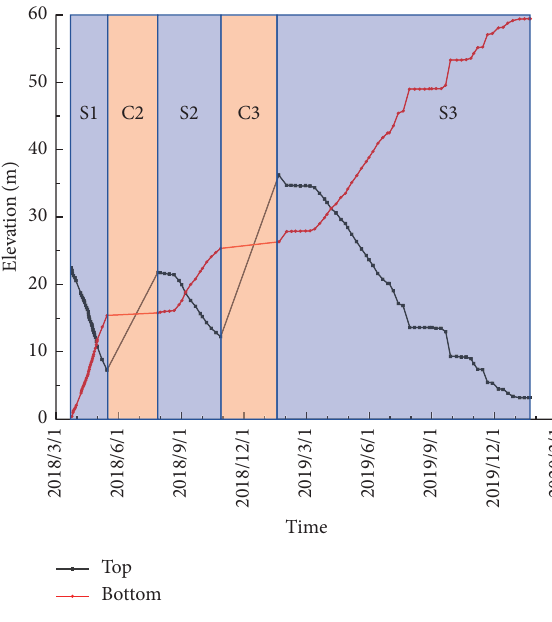
Figure 8: The top elevation of